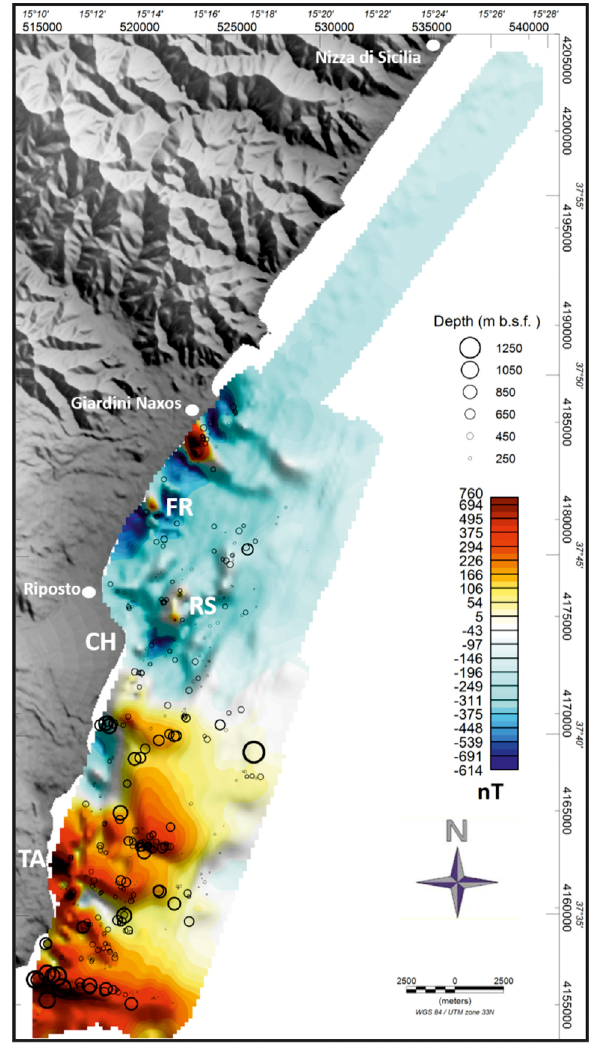
Figure 10. Reduced to the pole magnetic anomaly map (inclination 53.3°; declination 2.9°) offshore Mt. Etna. Grid cell size is 200 m. Unfilled black circles indicate the geographical positions of Euler’s deconvolution magnetic sources. CH (Chiancone volcanoclastic de- posit), TA (Timpa area), RS (Riposto Shoal), FR (Fondachello